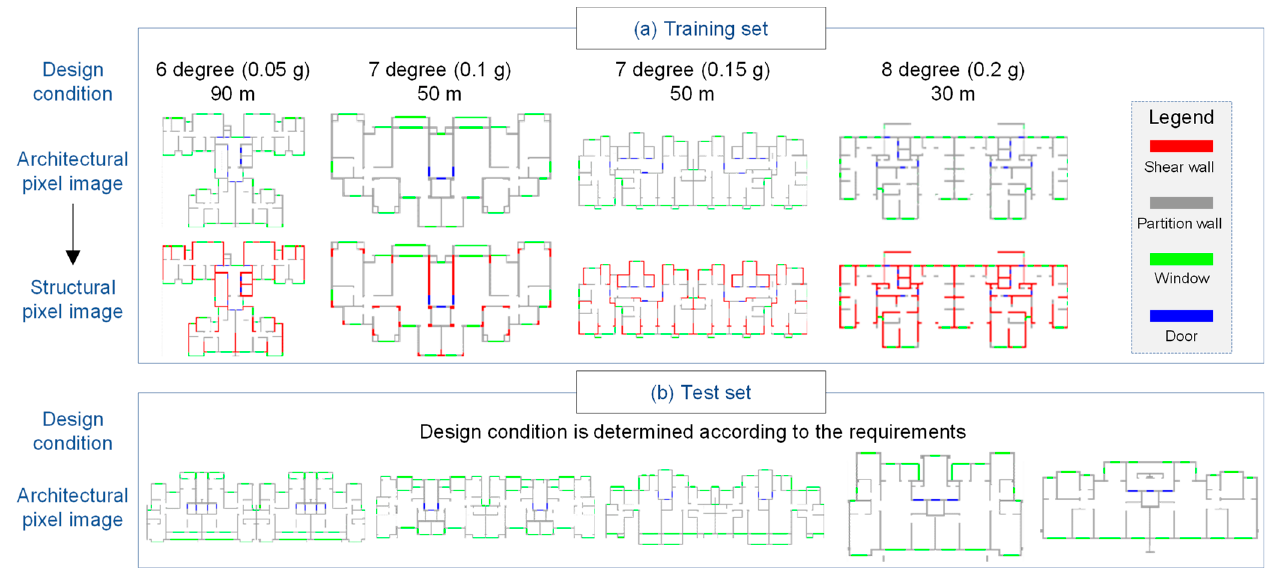
Figure 5. Typical datasets for StructGAN-PHY training [14].